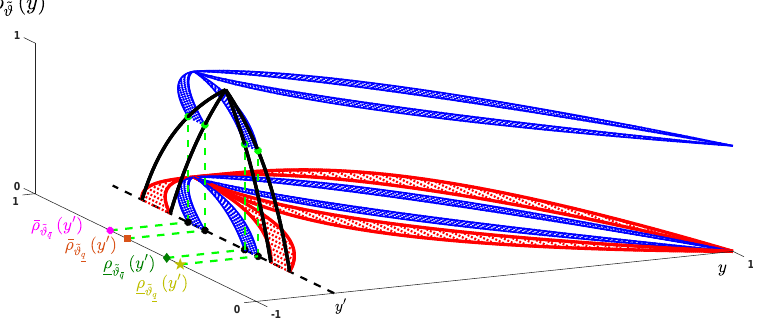
Figure 4. Type-3 membership